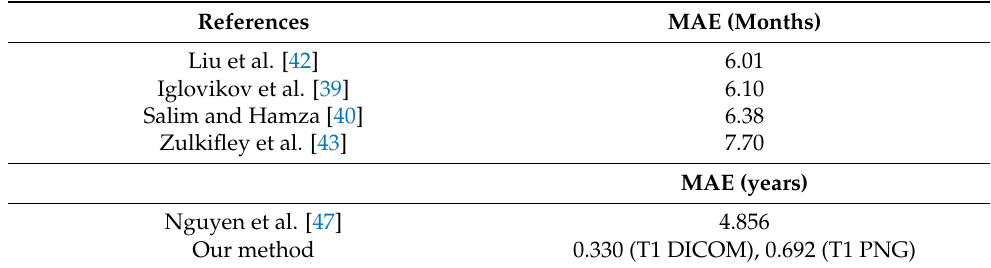
Table 4. Results of performance of the presented method and other solutions for the estimation of bone age based on